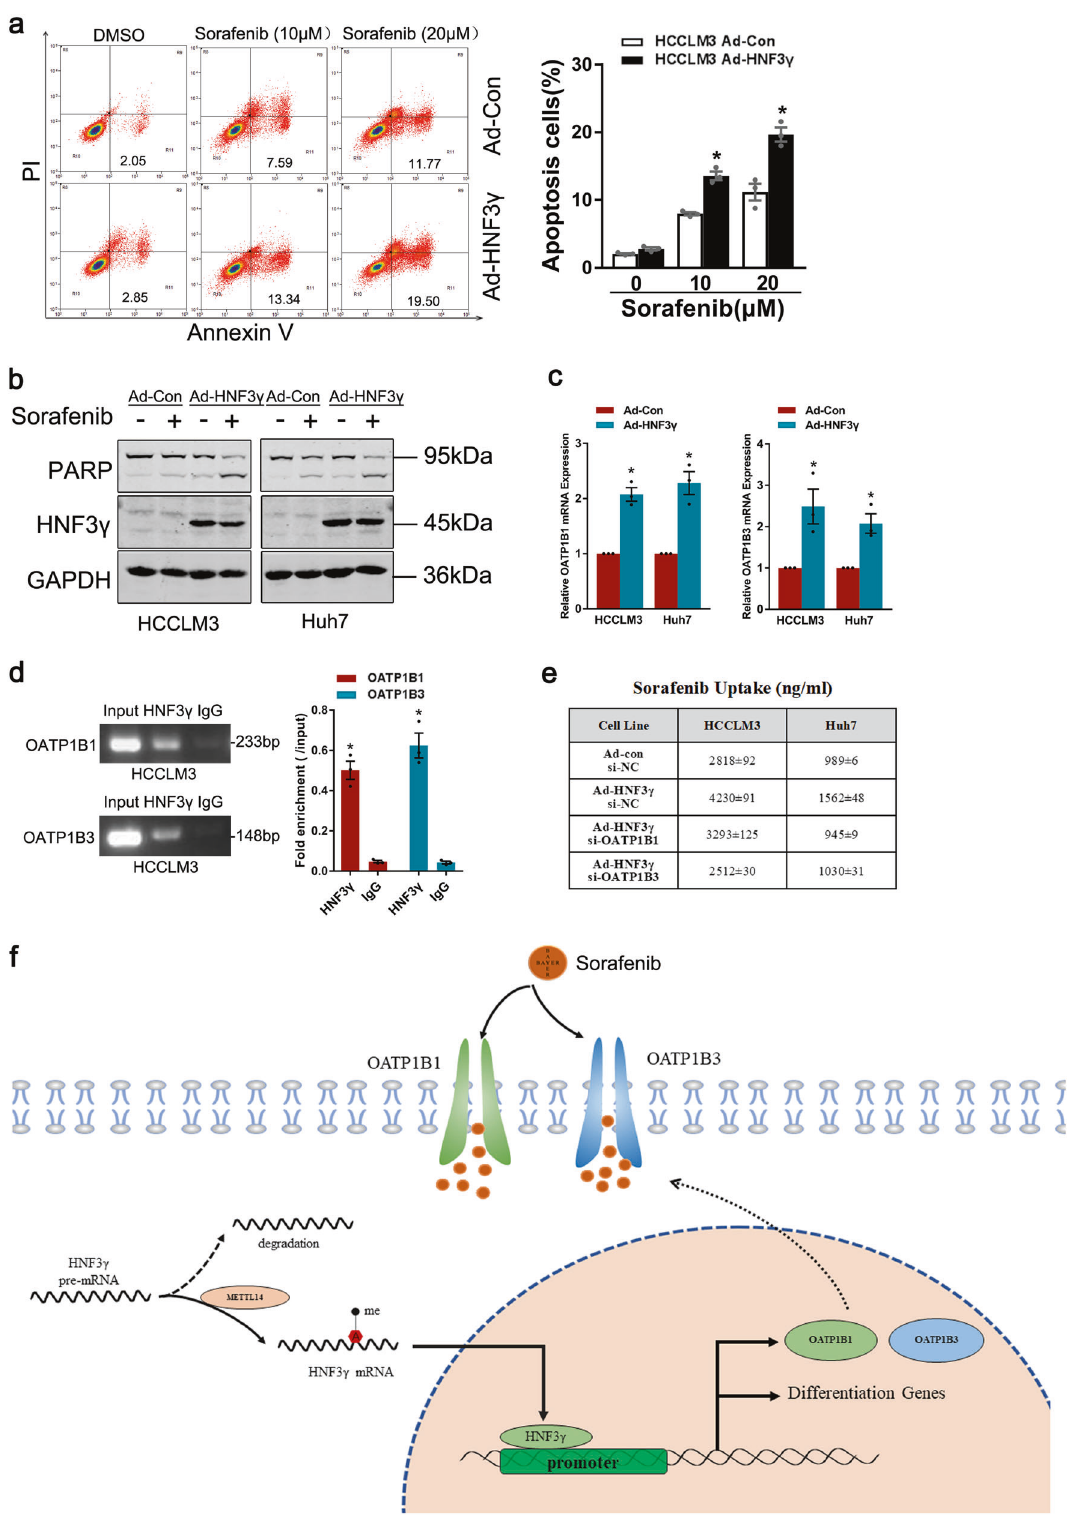
Fig. 7 HNF3 γ sensitizes HCC cells to sorafenib treatment. a HCCLM3 cells infected with Ad-HNF3 γ or Ad-Con were treated with sorafenib (10 µM or 20 µM) for 24 h, and apoptotic cells were detected by fl ow cytometry. Results were expressed as means ± SEM. b HCC cells infected with Ad-HNF3 γ or Ad-Con were treated with sorafenib (10 µM) for 48 h and then subjected to western blot analysis. c The expression of OATP1B1 and OATP1B3 in HCC cells infected with Ad-HNF3 γ or Ad-Con was determined by real-time PCR. d HCCLM3 cells were subjected to a ChIP assay with anti-HNF3 γ or anti-IgG antibody followed by qPCR analysis. e HCCLM3 or Huh7 cells were infected with Ad-HNF3 γ or Ad-Con followed by siRNA transfection as indicated. The cells were then treated with sorafenib for 48 h, and the intracellular sorafenib was determined by mass spectroscopy as described in “ Methods ” . f Schematic diagram of HNF3 γ -enhanced HCC cell differentiation and sorafenib